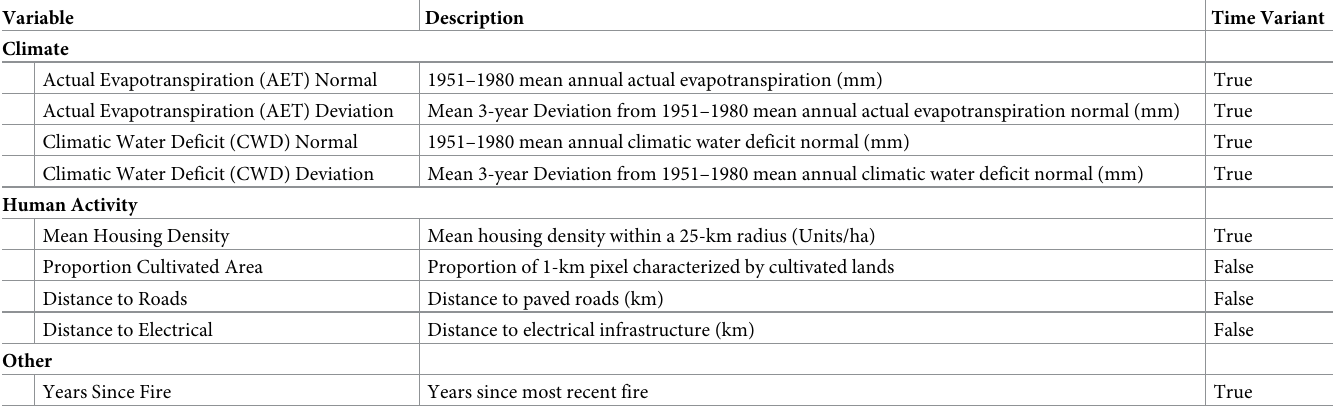
Table 1. Description of variables used to estimate annual fire